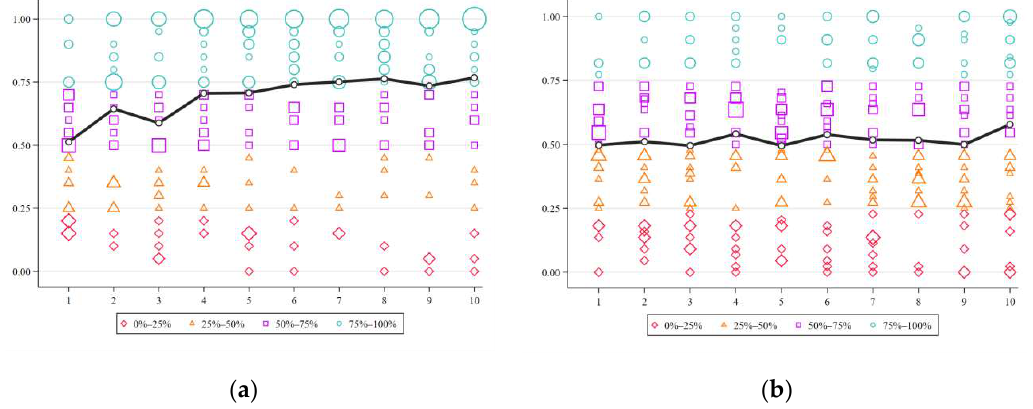
Figure 2. ( a ) Investment made by player A in FREE, ( b ) effort chosen by player B in FREE. Circles represent choices above 75% of the total, squares represent choices of 50–75%, triangles represent choices of 25–50%, and diamonds represent choices below 25%. The solid line portrays the mean choices per period.